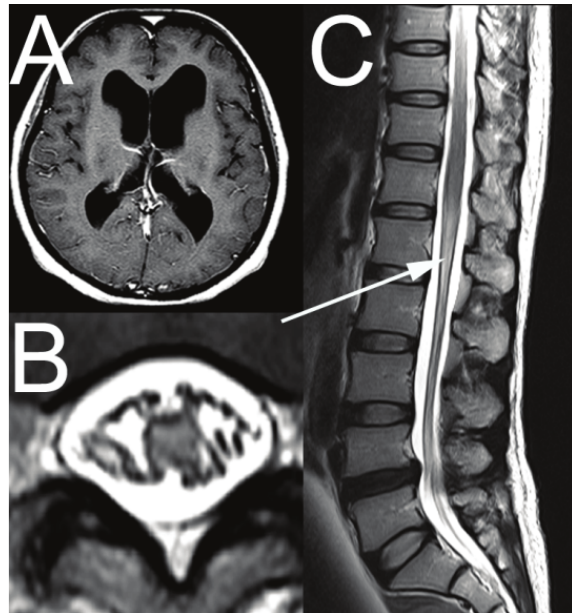
Figure 1: Brain MRI shows marked enlargement of all ventricles (A) and T2-weighted axial (B) and sagittal (C) MR images of the lumbar spine demonstrate increased signal intensity lesion at the level of conus medullaris (arrow). The lesion is diffuse and symmetrical and involves the whole conus medullaris on axial